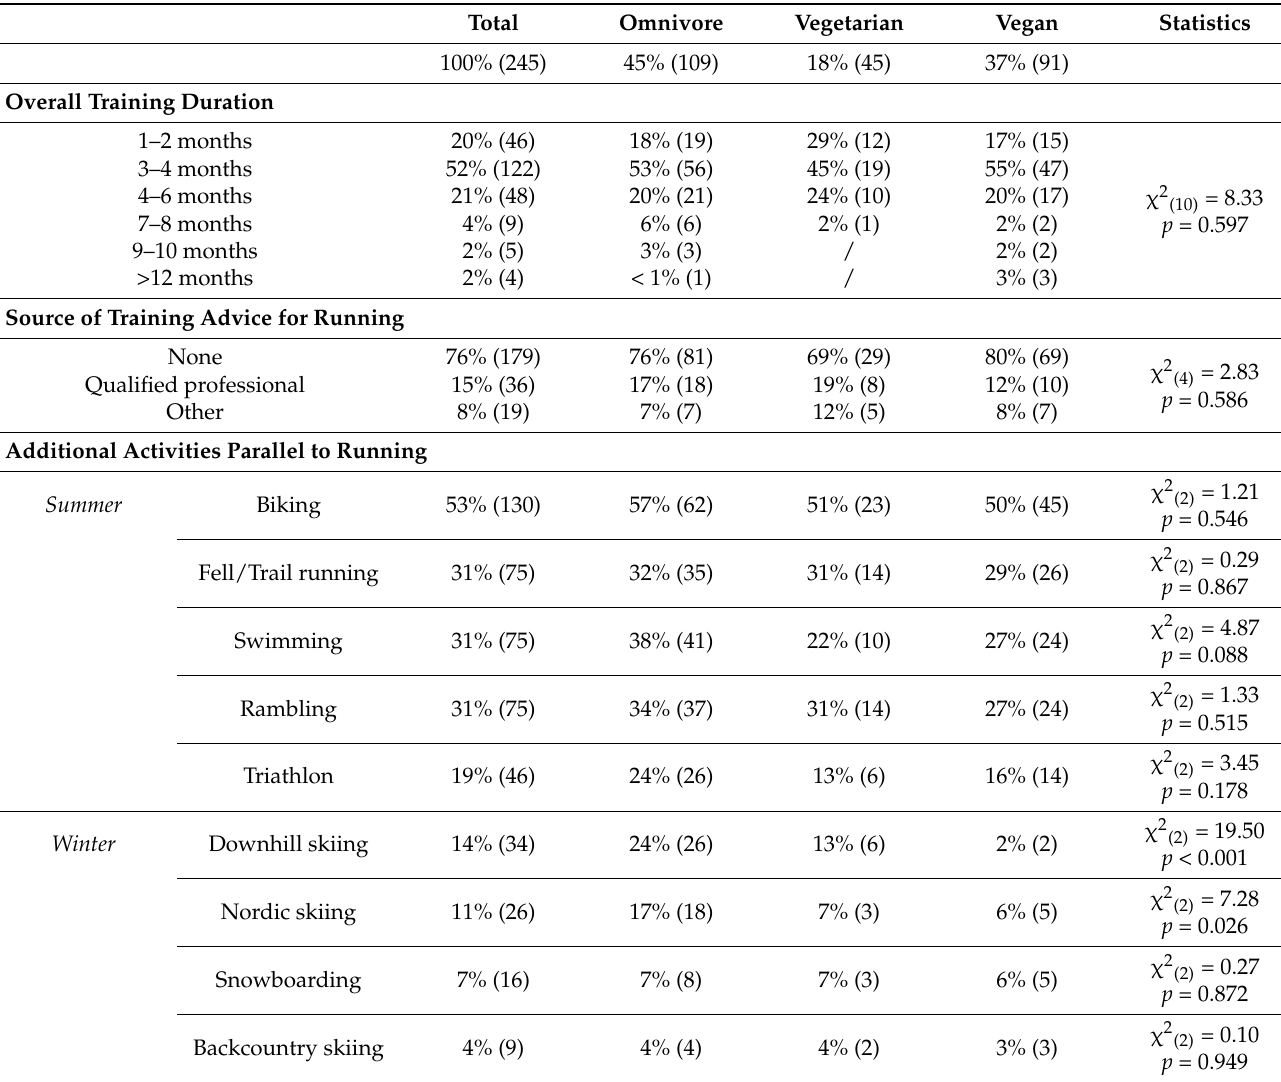
Table 2. Generic Training Details of Subjects by Dietary